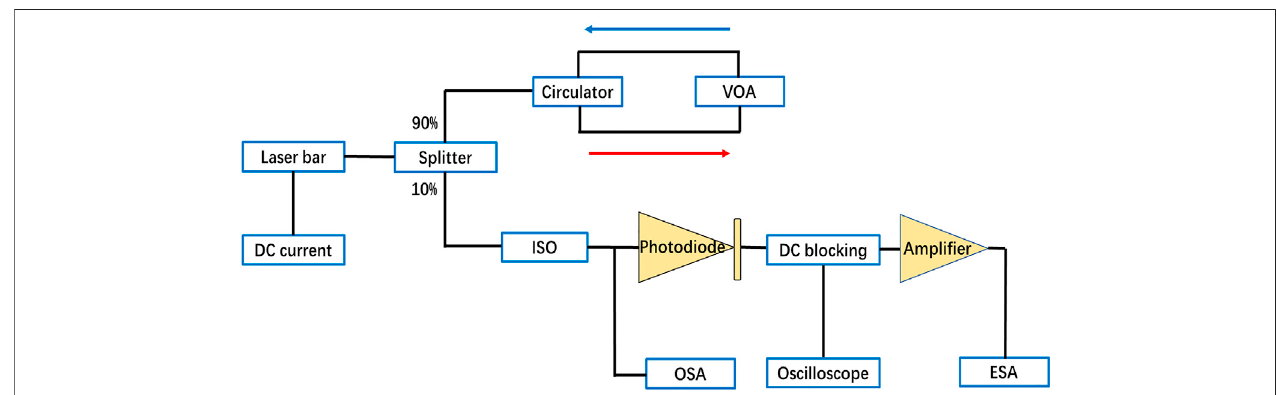
FIGURE 2 | Experimental arrangement for the measurements of optical and RF spectra of QD lasers under different optical feedback. VOA, variable optical attenuator; ISO, optical isolator; OSA, optical spectrum analyzer; ESA, electrical spectrum analyzer.